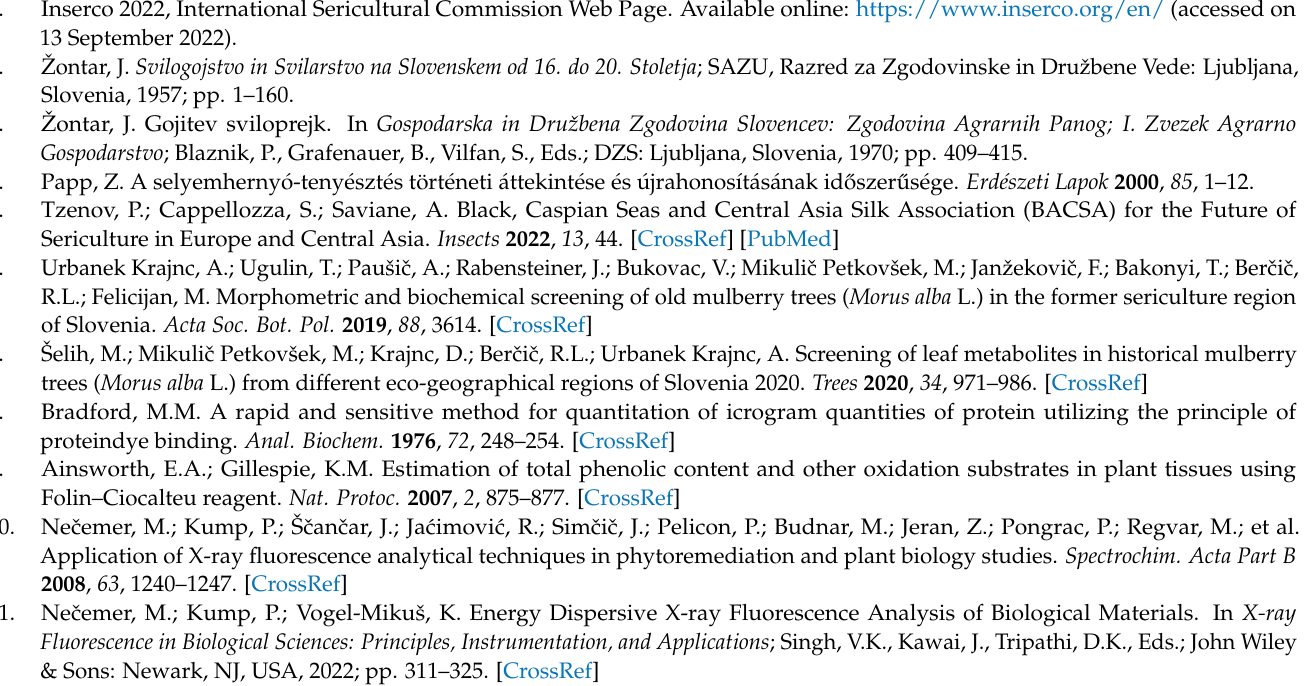
test; Table S3: The mean concentrations of the macro- and micronutrients in leaves of Slovenian, Hungarian old mulberry genotypes, reference sericultural and fruit varieties; Table S4: Differences in mean silkworm weight, fresh cocoon weight and silk thread parameters among Slovenian, Hungarian mulberry varieties, reference sericultural varieties and fruit varieties. n , number of repetition; Table S5: PCA scores of the main PC1 and PC2